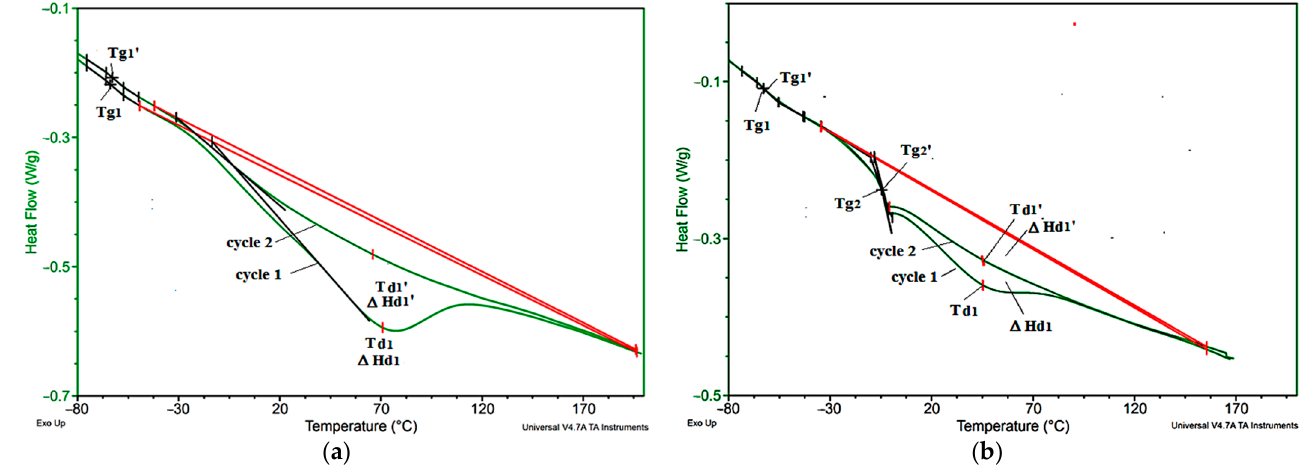
Figure 7. DSC thermogram of selected sample: ( a ) VEF and ( b ) VEFX15. On the basis of the DSC thermogram, it was observed that in the VEF foam during the